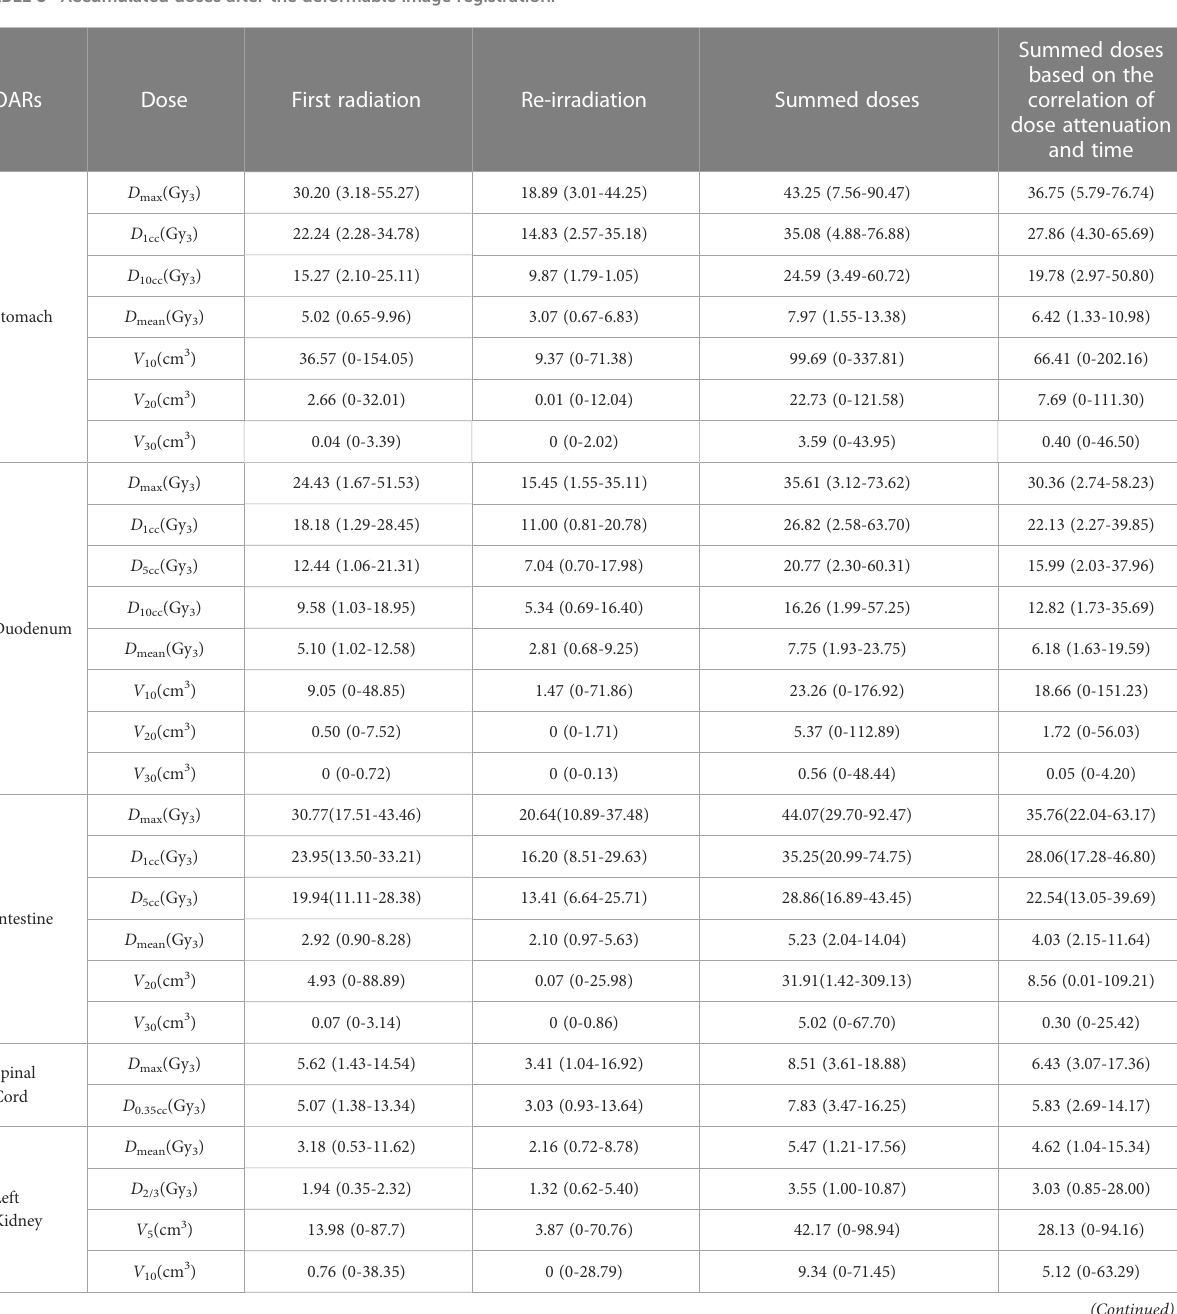
TABLE 3 Accumulated doses after the deformable image